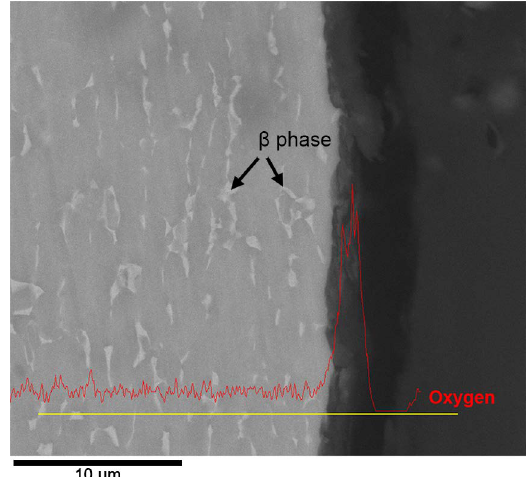
Figure 5. SEM micrograph of the cross-section showing the surface oxide